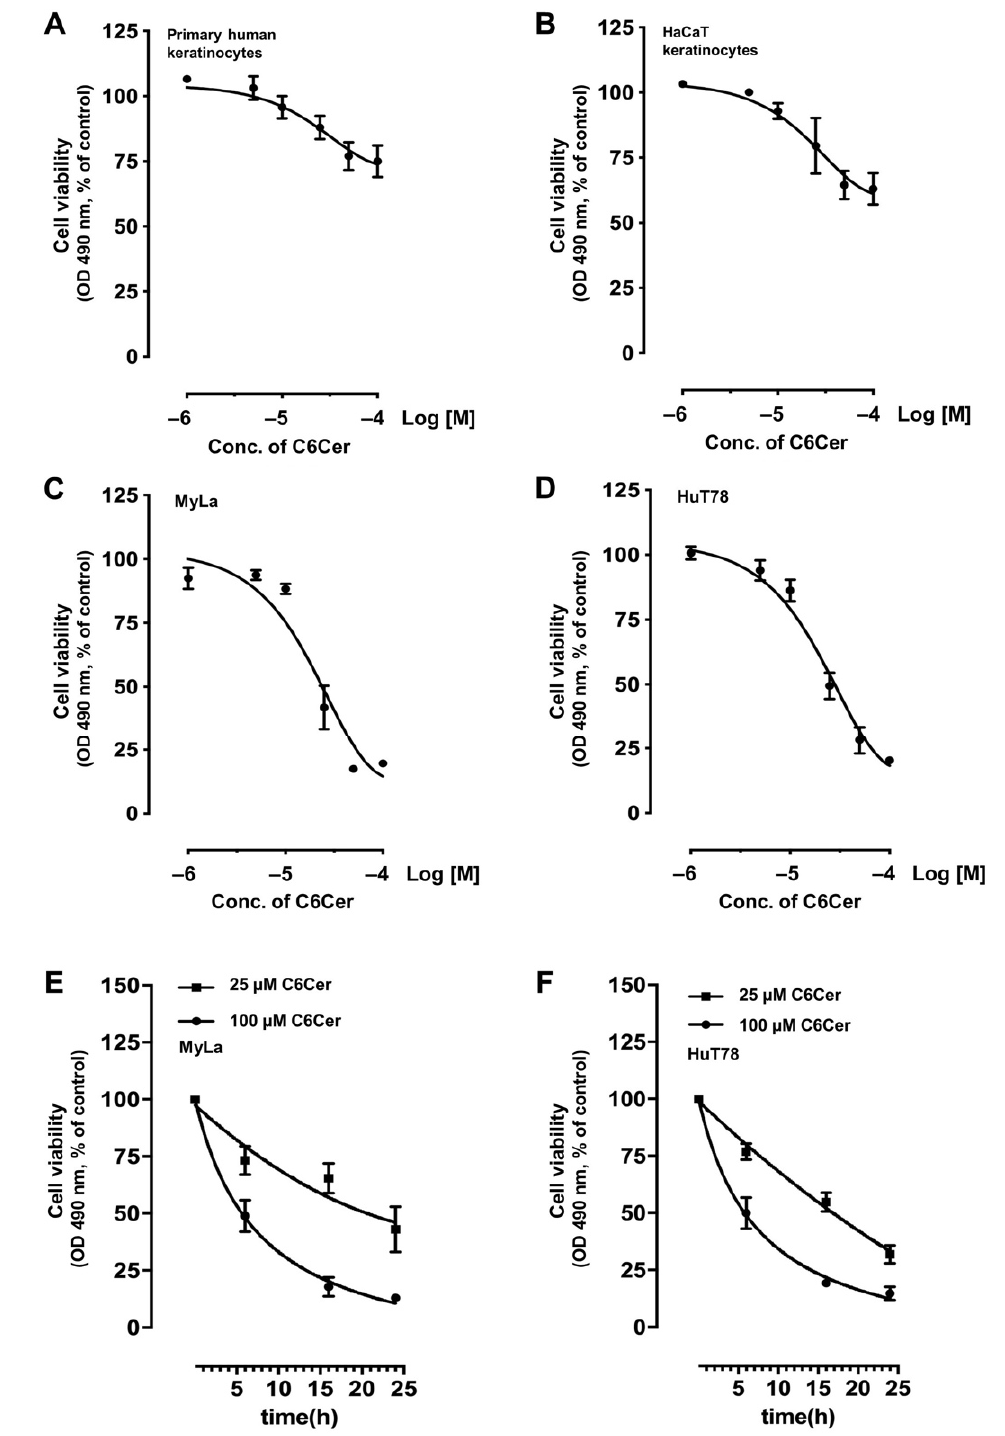
Figure 1. C6 ceramide decreases cell viability in keratinocytes and cutaneous T cell lymphoma cell lines. Dose-dependent effect of C6 ceramide (C6Cer) on cell viability of primary human keratinocytes ( A ) and HaCaT keratinocytes ( B ). Dose- and time-dependent effect of C6Cer on cutaneous T cell lymphoma cell lines MyLa ( C , E ) and HuT78 ( D , F ). The cells in A–D were treated with 1, 5, 10, 25, 50, and 100 µ M C6Cer for 24 h. The cells in E and F were treated with 25 and 100 µ M C6Cer for 6, 16, and 24 h. Cell viability was determined by MTS assay. All data are shown as means ± SEM ( n =